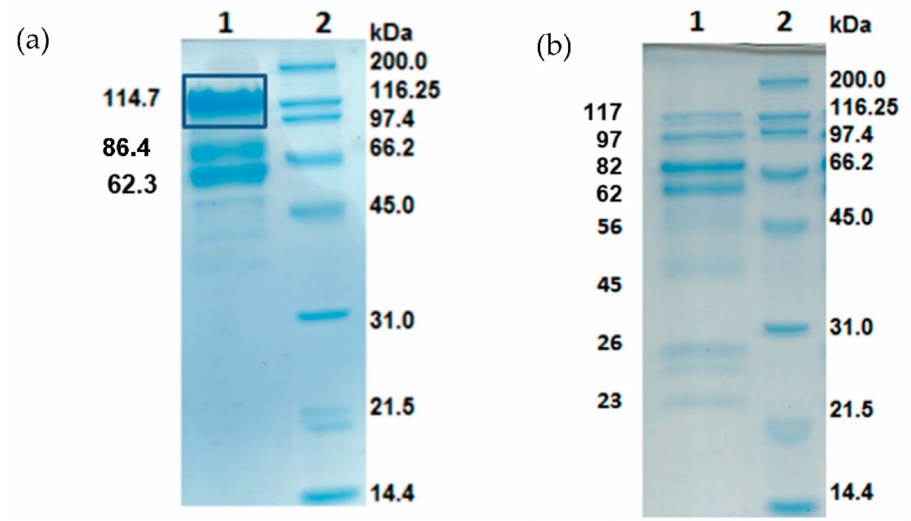
Figure 2. ( a ) Electrophoretic profile of Novozym 188. Lane 1: 3.74 µ g from Novozym 188. Lane 2: standard proteins of known molecular mass: myosin, β -galactosidase, phosphorylase b, BSA, ovalbumin, carbonic anhydrase, soybean trypsin inhibitor, lysozyme. ( b ) Electrophoretic profile of Glukosidase-1000. Lane 1: 3.02 µ g from the commercial enzyme preparation. Lane 2: the mentioned standard proteins of known molecular